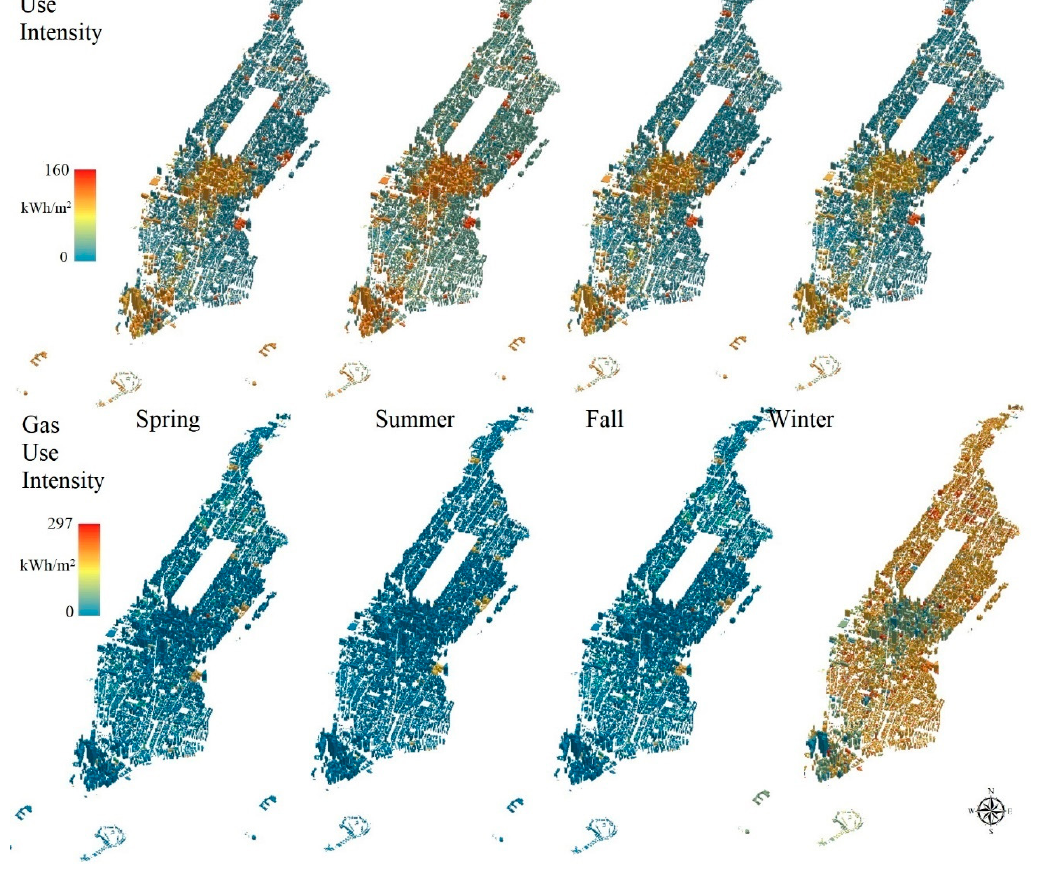
Figure 8. Seasonal energy-use intensity in Manhattan, NYC, in 2012.